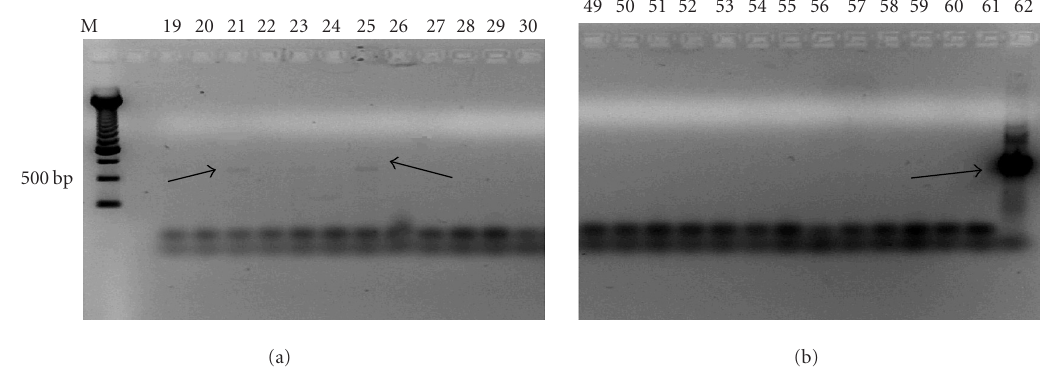
Figure 10. M: 250-bp DNA ladder. Lanes 1–6: time course samples of KM71H (clone 1) cells. Lanes 7–12: time course samples of KM71H( clone 2) cells. Lanes 13–18: time course samples of KM71H (uninduced) cells. Lanes 19–22: time course samples of X-33 (clone 1) cells. Lanes 23–26: time course samples of X-33 (clone 2) cells. Lanes 27–30: time course samples of X-33 (uninduced) cells. Lanes 31–47: duplicates of KM71H cells without reverse transcriptase enzyme (no RT control). Lanes 49–60: duplicates of X-33 cells without reverse transcriptase enzyme (no RT control). Lanes 48 & 62 vector with pleurocidin DNA insert (positive control). Lane 61: PCR Master mix without DNA template (negative control). (a) Transcribed cDNA bands at 590 bp from transformed X-33 cells at